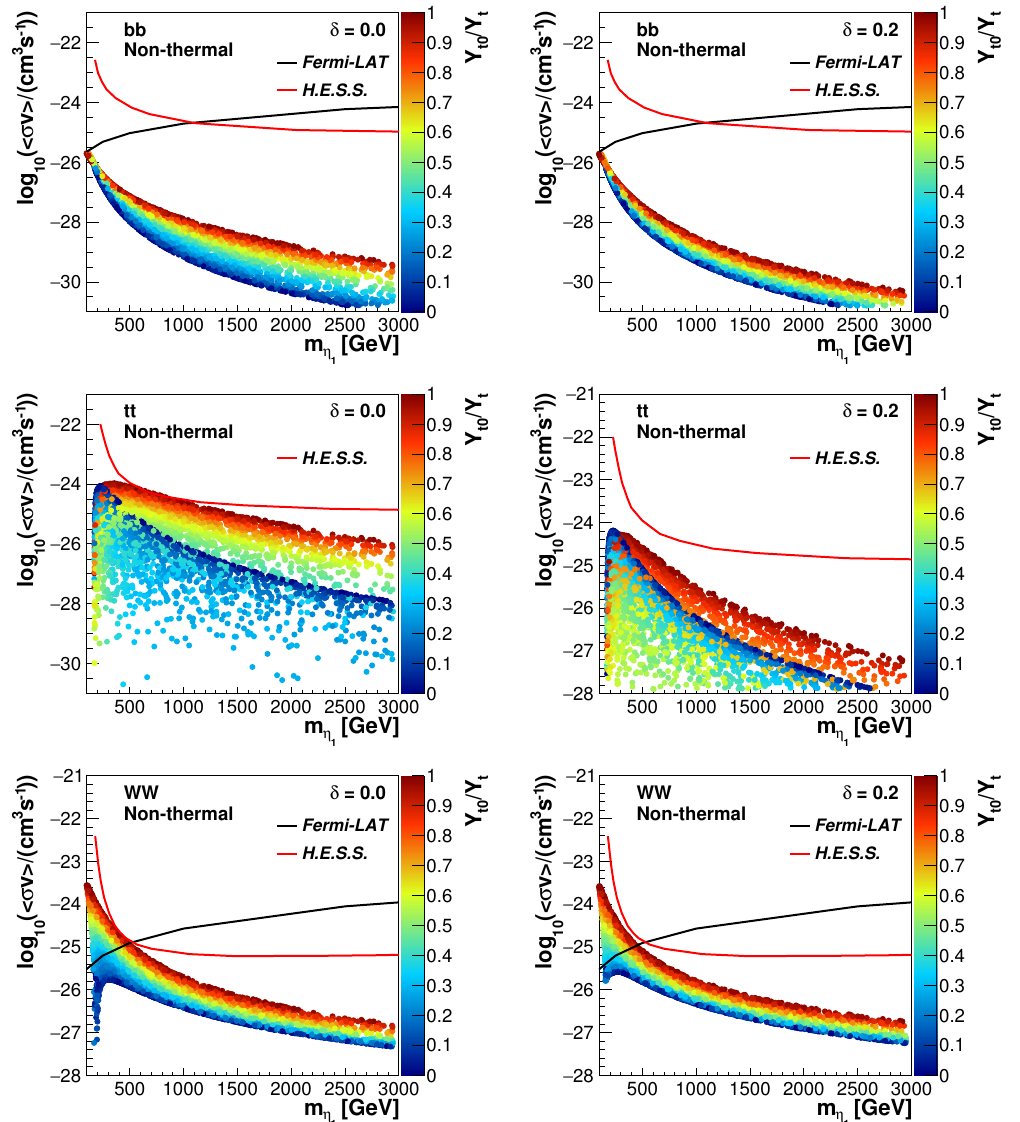
Figure 9 . Same as (cid:12)gure 8, assuming saturated relic abundance in the whole parameter space. the middle row of (cid:12)gure 8 varies between ( (cid:27) v ) = 10 (cid:0) 25 (cid:4) 10 (cid:0) 31 cm 3 /s for (cid:14) = 0 EXP t (cid:22) t and between ( (cid:27) v ) = 10 (cid:0) 25 (cid:4) 10 (cid:0) 28 cm 3 /s for (cid:14) = 0 : 2 . The cross section EXP t (cid:22) t